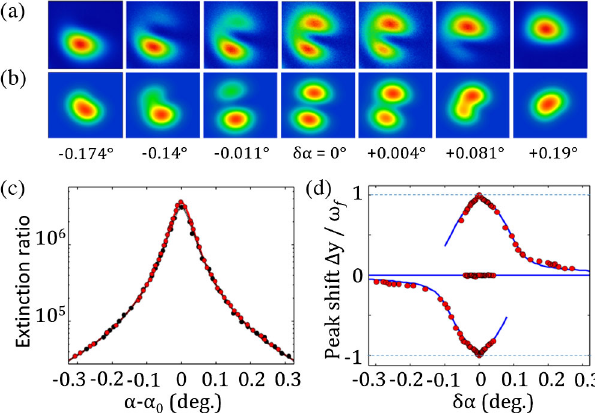
FIG. 5. Measured (a) and simulated (b) evolution of the modal mapping through maximum extinction for reflectivity from the air side off a glass surface (BK7) for p polarization. (c) Red symbols: extinction ratio for different analyzer angle α shifts as explained in the text. Black symbols: reference measurement with the analyzer placed just after the polarizers. The positions of the intensity extrema are shown in units of beam waist ω f at